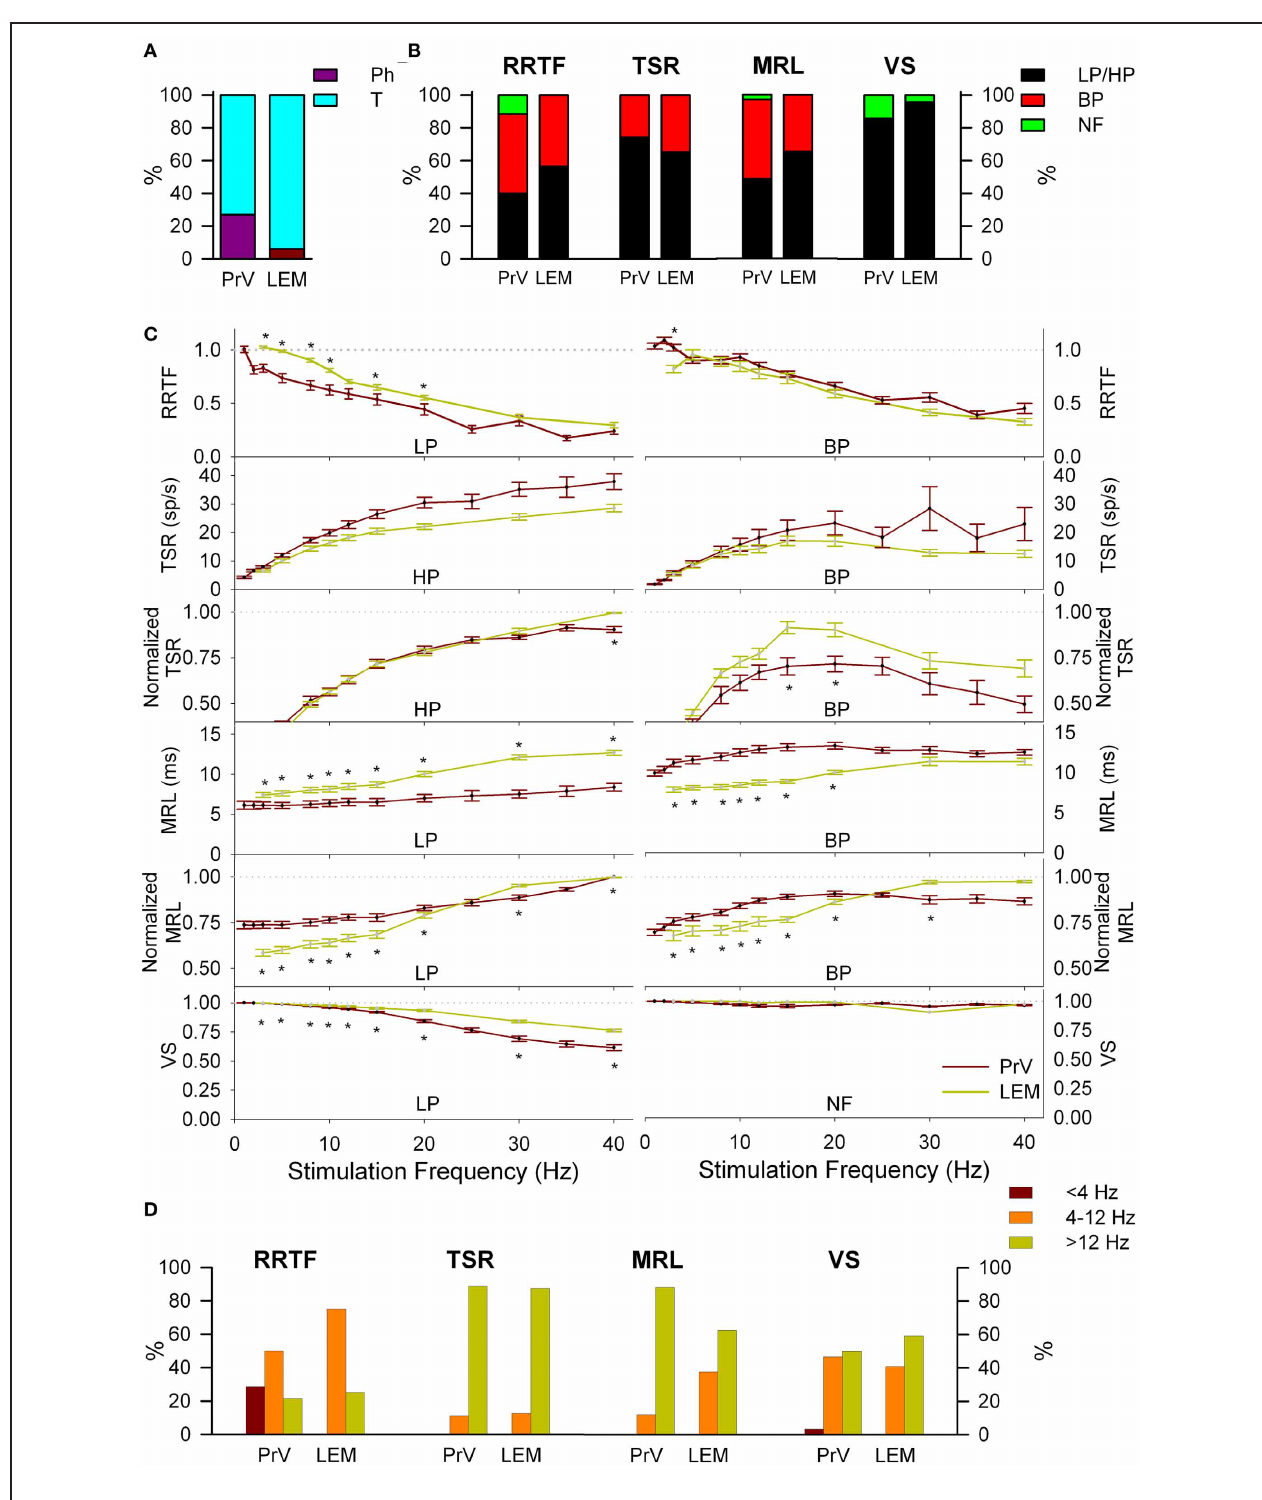
FIGURE 4 | Comparison between PrV and lemniscal (LEM) recordings. (A) Percentages of phasic (Ph) and tonic (T) responses in PrV and lemniscal recordings. (B) Percentages of the different filtering profiles for repetition rate transfer function (RRTF), total spike response (TSR), mean response latency (MRL), and vector strength (VS). (C) Mean RRTF, TSR, MRL, and VS values of low-pass (LP) or high-pass (HP) (left) and band-pass (BP) profiles (right) of PrV and lemniscal recordings. Significant